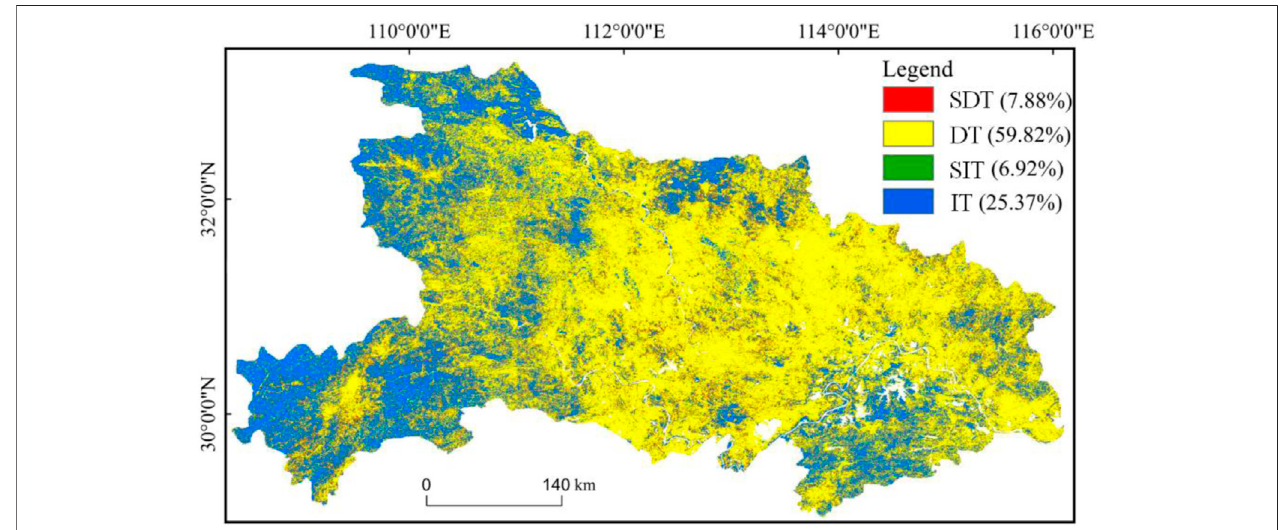
FIGURE 6 | Change trends in annual NPP within Hubei Province between 2001 and 2012.